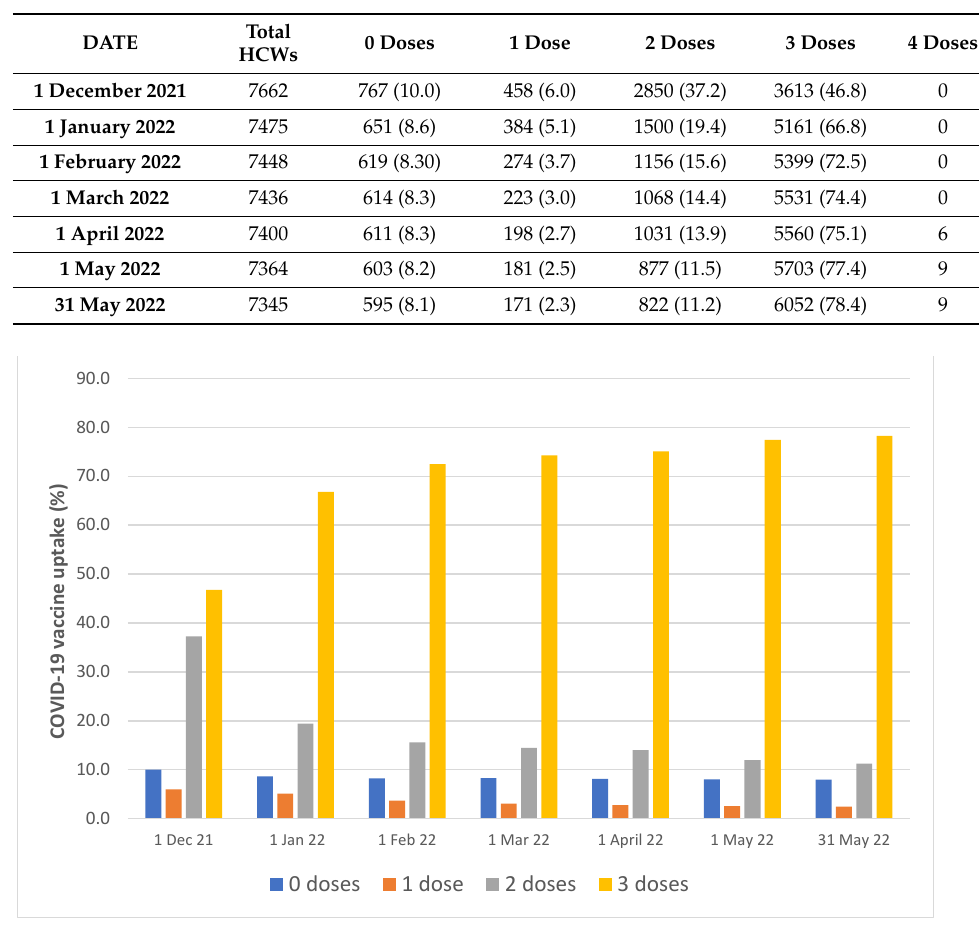
Table 2. COVID-19 vaccination coverage of health care workers of ASUGI, by number of doses and calendar month, 1 December 2021–31 May 2022. Number and row percentage (%).